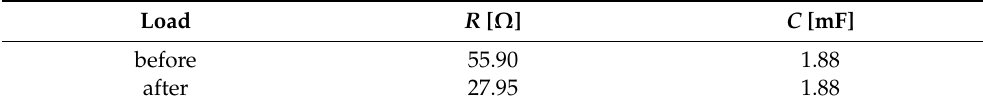
Table 22. Load parameters for steady states before and after load change.